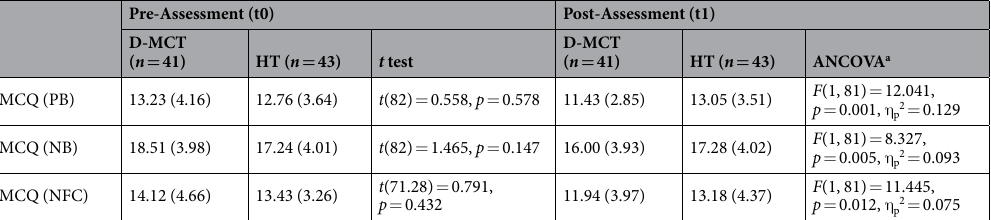
Table 2. Group Comparisons (Intention to Treat Sample) and Results of the ANCOVAs for Metacognitive Beliefs for Pre- and Post-Assessment. Note D-MCT = Metacognitive Training for Depression, HT = health training, MCQ (NB) = Metacognition Questionnaire, Negative Beliefs; MCQ (NFC) = Metacognition Questionnaire, Need for Control; MCQ (PB) = Metacognition Questionnaire, Positive Beliefs. a Difference scores (baseline to post) served as dependent variables; baseline scores were entered as a covariate. Effect sizes for η p2 refer to small ( η p2 ≈ 0.01), medium ( η p2 ≈ 0.06), and large ( η p2 ≈ 0.14) effects,